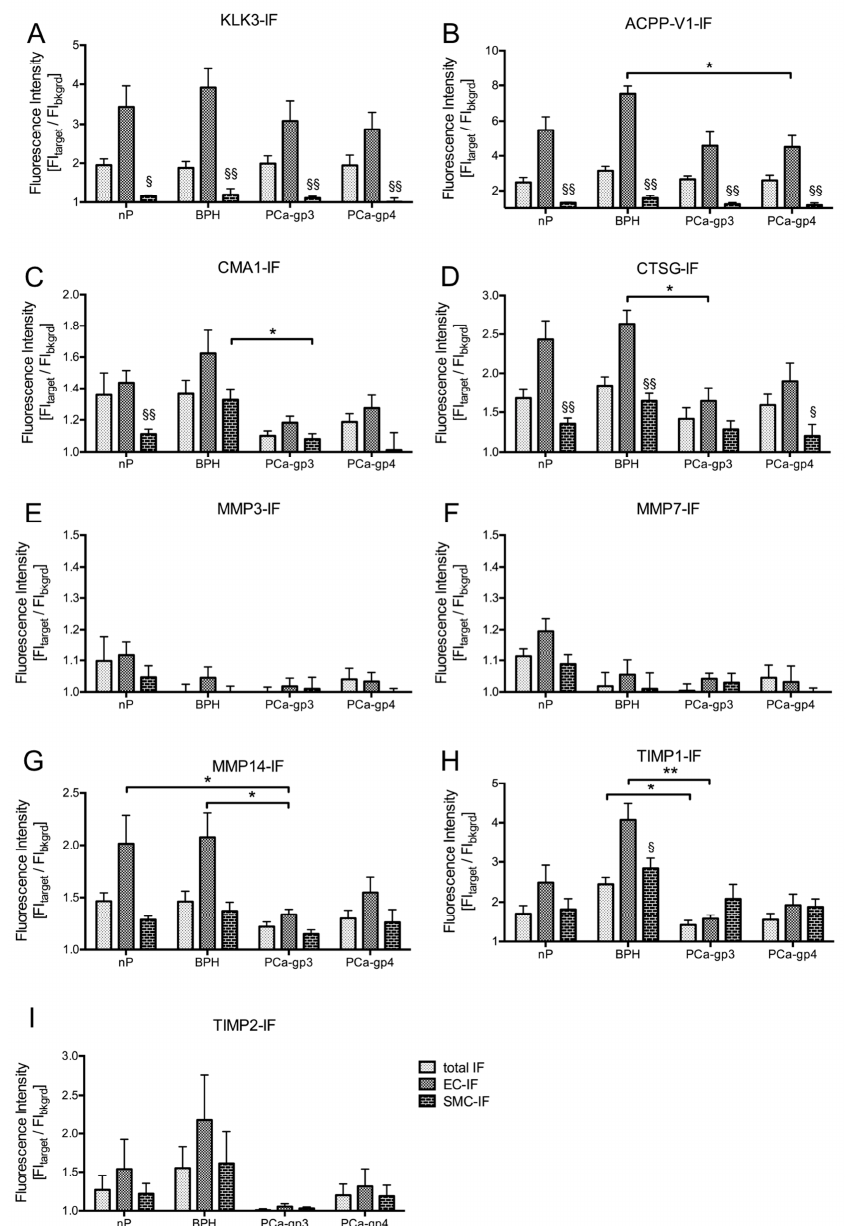
Figure 4. Cellular distribution in prostate tissue. Data (mean (SEM)) are presented as fluorescence intensity [FI target /FI control ]; background fluorescence (bkgrd) = 1. Total fluorescence included complete tissue area omitting the lumen. Smooth muscle cells (SMC) were identified by anti-smooth muscle cell actin staining (green fluorescence, cf. Figure 2); epithelial cells (EC) area was delineated from DIC images. Note the differences in Y-axis scaling. Differences in fluorescence intensities were not significant for KLK3-IF ( A ), MMP3-IF ( E ), MMP7-IF ( F ) and TIMP2-IF ( I ). Note that the total-IF and SMC-IF is unaltered for ACPP-V1 ( B ), CMA1 ( C ) and CTSG ( D ) whereas epithelial (EC)-IF is significantly lower in PCa compared to BPH, indicating contribution of interstitial cells to total-IF. A comparable trend not reaching significance level ( p < 0.05) is seen for MMP14 ( G ). In contrast, the significant reduction of TIMP1 total-IF is reflected by significant reduction of EC-IF ( H ). Kruskal–Wallis test with post-hoc Dunn’s Multiple Comparison test as indicated by bars (* p < 0.05; ** p < 0.01); § indicates significant difference between EC and SMC; § p < 0.05; §§ p < 0.01.